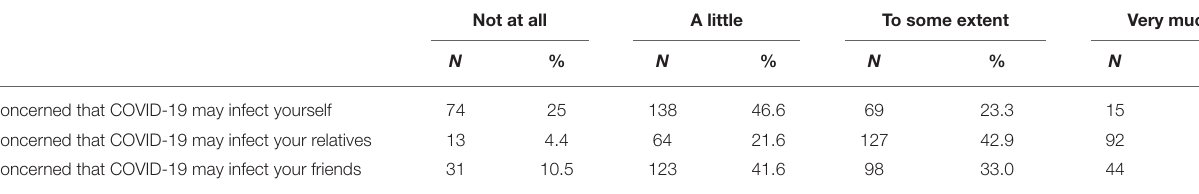
TABLE 2 | Frequencies distribution of COVID-19 contagion